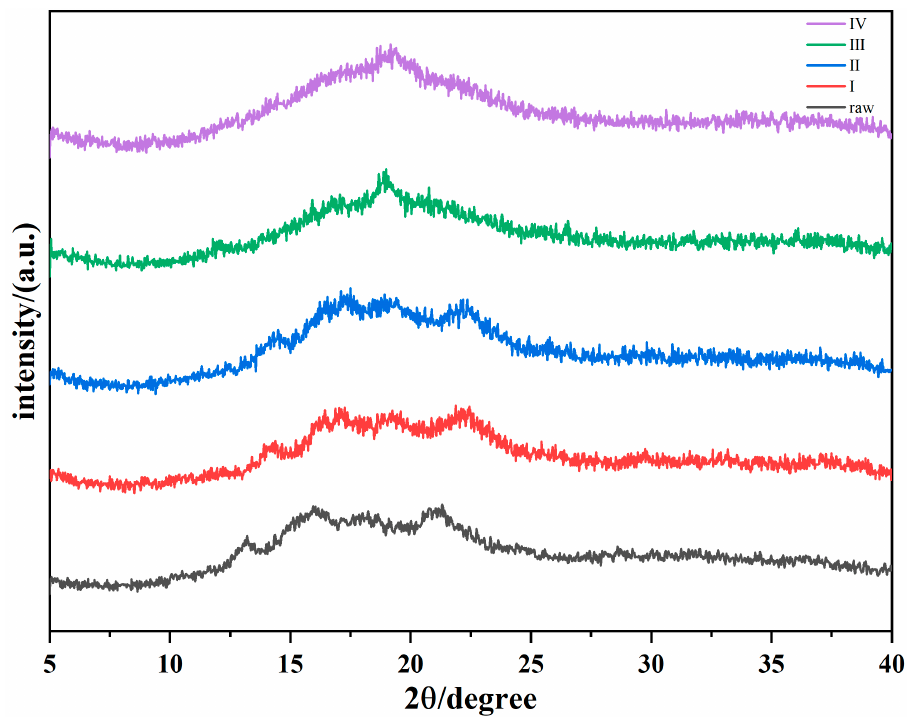
Figure 2. XRD pattern of oats from different zones at 20% moisture. Raw: native oat; I: oat in mixing zone; II: oat in cooking zone; III: oat in melting zone; Ⅳ : extrudate. Table 2. Positions of the diffraction peaks for oats in different extrusion zones and moisture content.